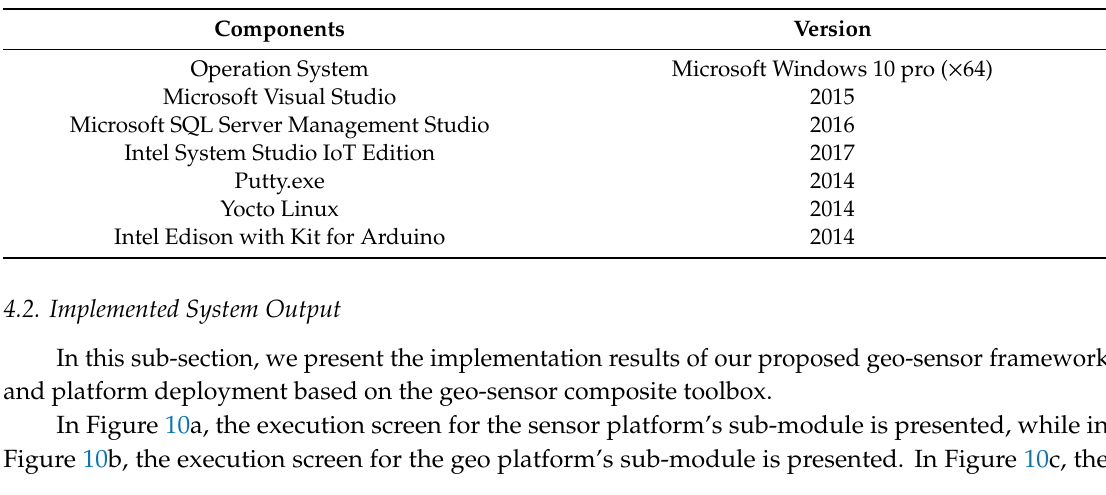
Table 1. Implementation environment of this system.